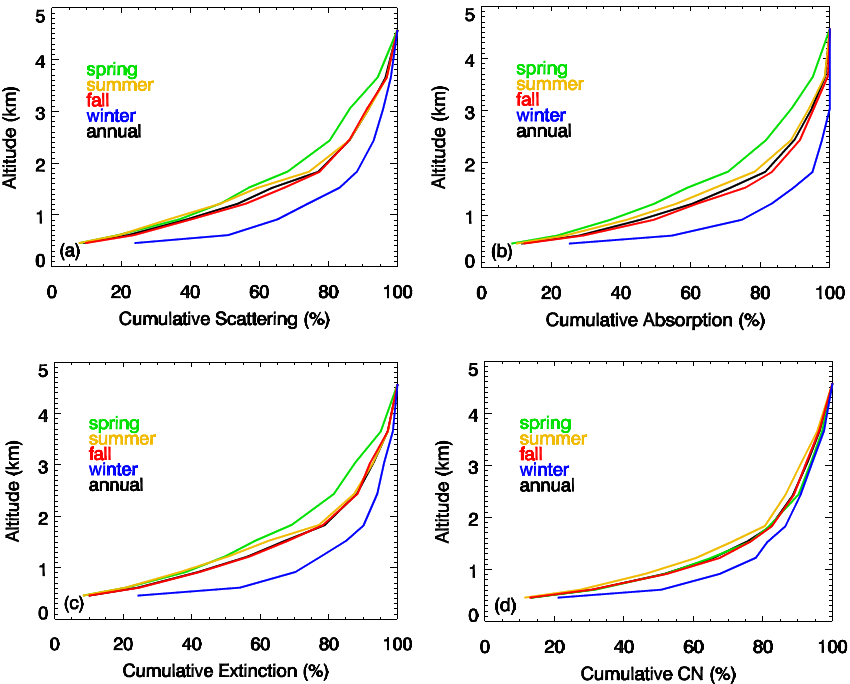
Fig. 11. Seasonal median plots showing the cumulative percentage of each extensive parameter in the lower atmospheric column (surface to 4.6kma.s.l.) that occurs at or below a given altitude.